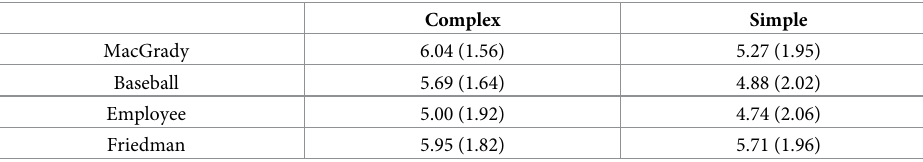
Statistics represent mean(standard